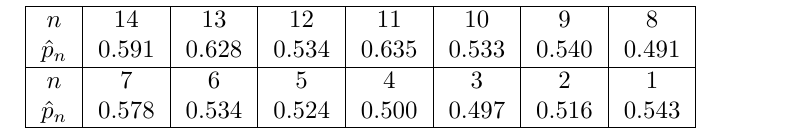
Table 5: Estimated p n , where n ∈ [1 ,